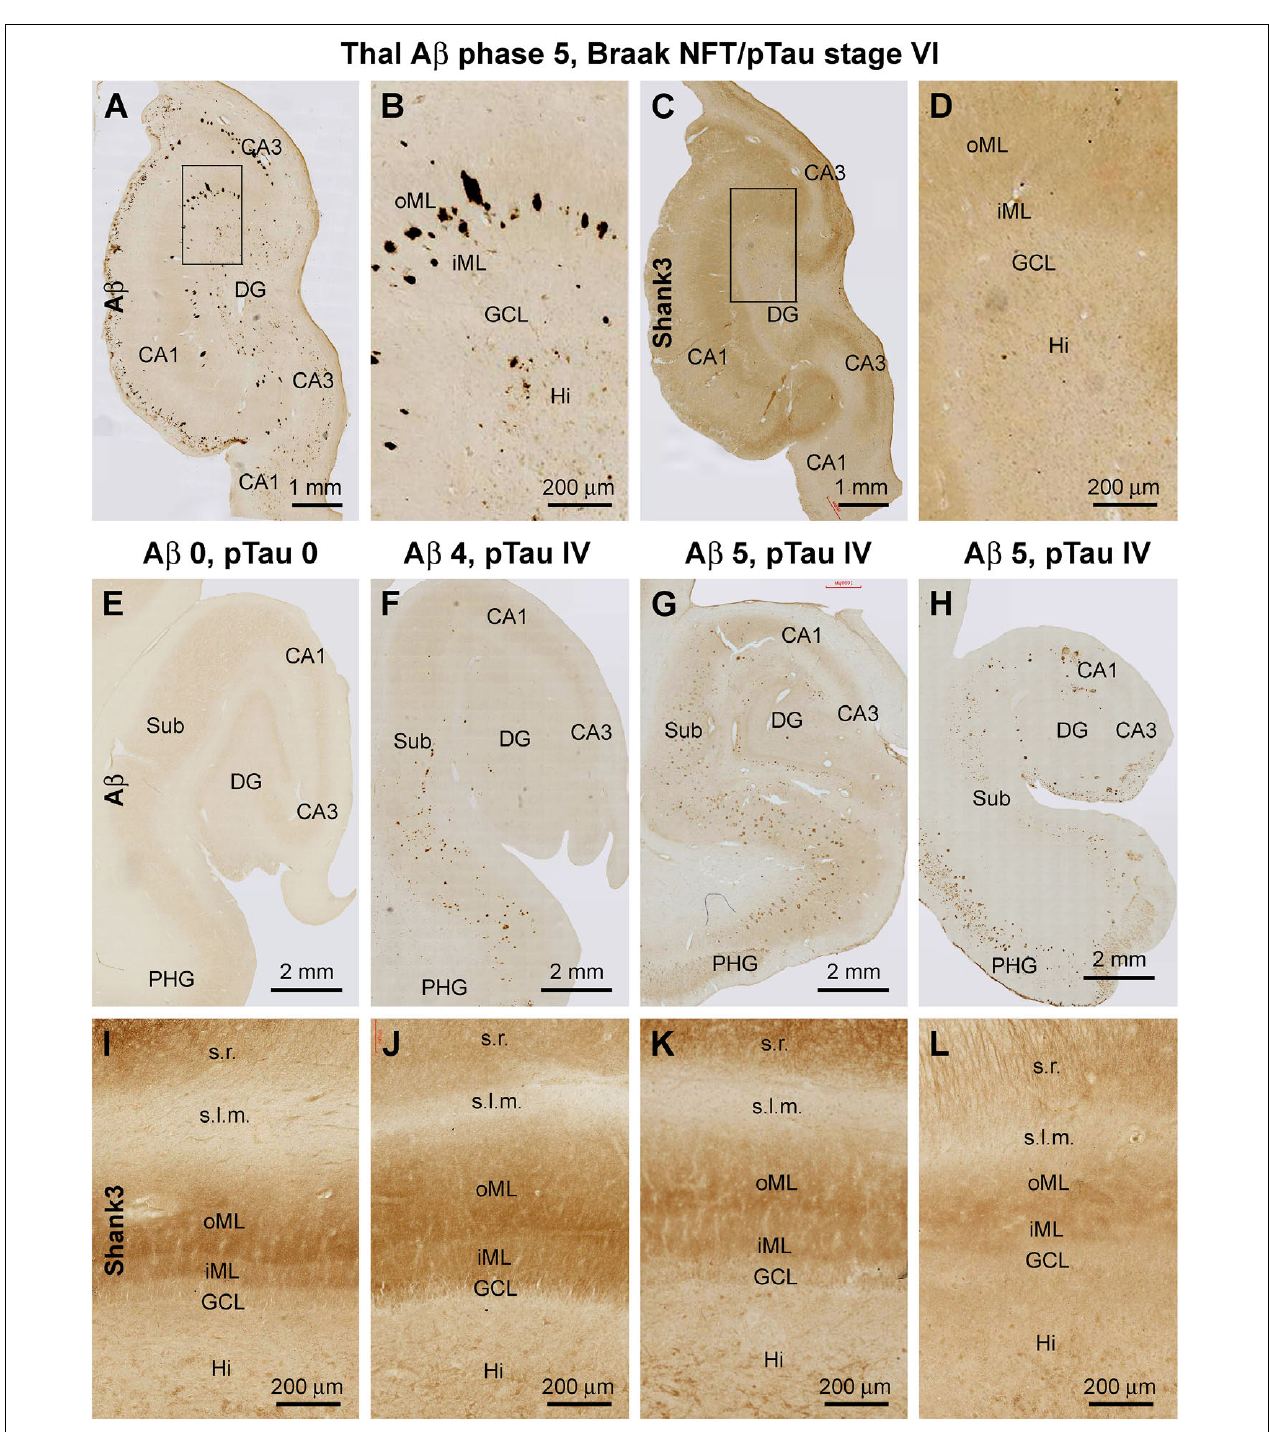
FIGURE 12 | Representative images illustrating altered Shank3 IR, the molecular layer of the dentate gyrus (DG) in human brains with late-stage Alzheimer’s disease (AD) pathology. The Braak staging of neurofibrillary tangle (images not shown) and Thal staging of β -amyloid (A β ) pathology for the cases are indicated for the groups of panels. Panels (A–D) show A β and Shank3 IR over the DG in an AD brain with severe brain atrophy; note the loss of Shank3 IR and its lamination over the inner (iML) and outer (oML) molecular layer. Panels (E–H) show images of A β IR over the hippocampal formation from an aged case without AD-type pathology (E) and with plaque lesions with increasing extent. Panels (I–L) show the intensity and lamination of Shank3 IR over the ML in these cases correspondingly. Note the decrease of Shank3 IR in the ML along with a disruption of the lamination (including thinning) that appears to be progressive in parallel with the severity of the A β lesion. Abbreviations are as defined in Figure 3 . Scale bars are as indicated in the image